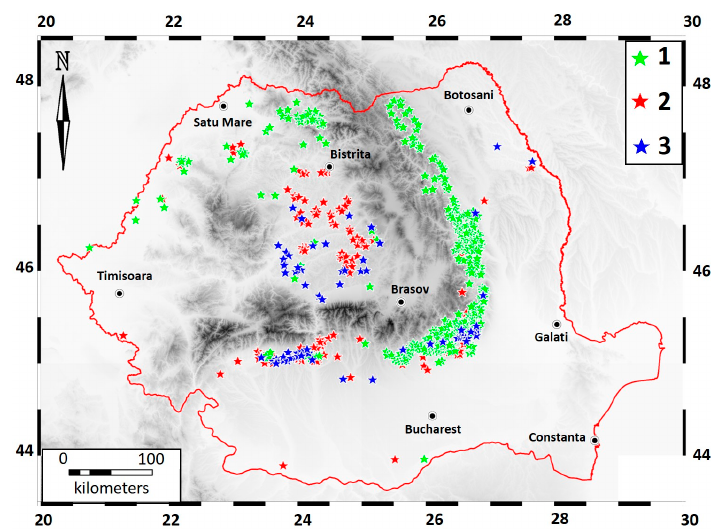
Figure 1. Distribution of the seeps inventoried by Tonescu, in 1953. 1: oil seeps (oil springs in the original catalogue); 2: gas seeps; 3: mud volcanoes (redrawn from